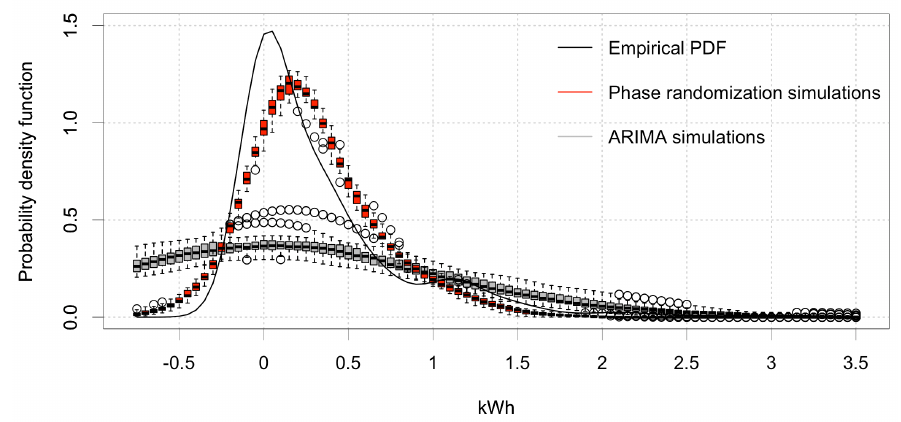
Figure 14. Comparison of phase randomization and ARIMA simulation techniques of the wavelet decomposed 5 a.m. hourly energy usage by DHW heater in RBSA home 13088 from Q2 2012–Q1 2013